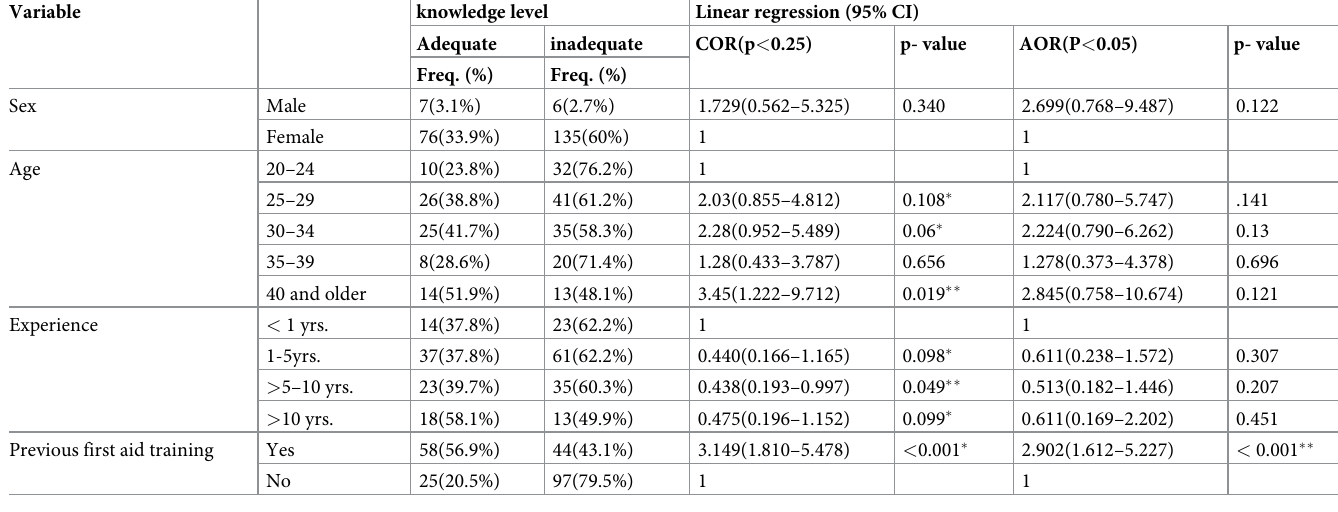
Table 5. Binary and multiple logistic regression analysis of selected factors affecting knowledge on first aid management of choking among government kindergar- ten school teachers in Addis Ababa, Ethiopia, 2019.